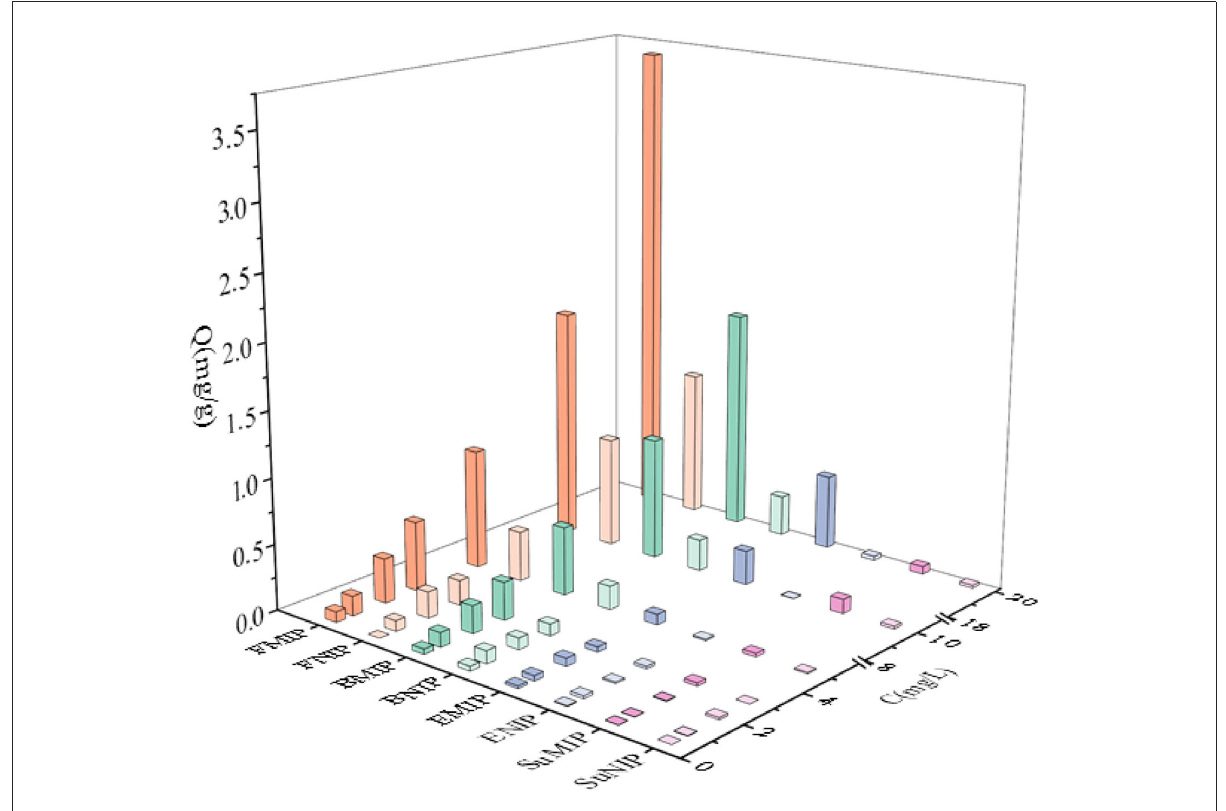
FIGURE7 Special adsorption of PyMIP and NIP. FMIP, fenvalerate; MIP, BMIP: buprofezin; MIP, EMIP, ethiprole; MIP, and SuMIP, sulfadiazine